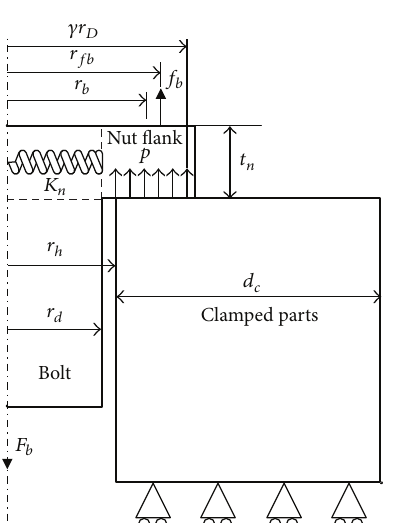
Figure 2: Bolted joint model under locking force.